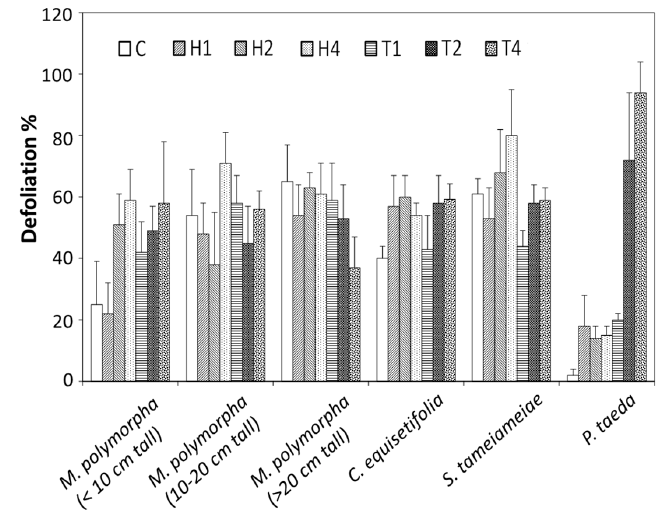
Figure 3. Defoliation of the forest plants ohia lehua ( Metrosideros polymorpha ) (native), Australian pine tree ( Casuarina equisetifolia ) (non-native), and pukeawe ( Styphelia tameiameiae ) (native), and loblolly pine ( Pinus taeda ) (non-native) by hexazinone and tebuthiuron at Kaohau site, 12 MAT. C (control, no hexazinone and tebuthiuron), H1 (hexazinone 1 kg ha − 1 ), H2 (hexazinone 2 kg ha − 1 ), H4 (hexazinone 4 kg ha − 1 ), T1 (tebuthiuron 1 kg ha − 1 ), T2 (tebuthiuron 2 kg ha − 1 ) and T4 (tebuthiuron 4 kg ha − 1 ).